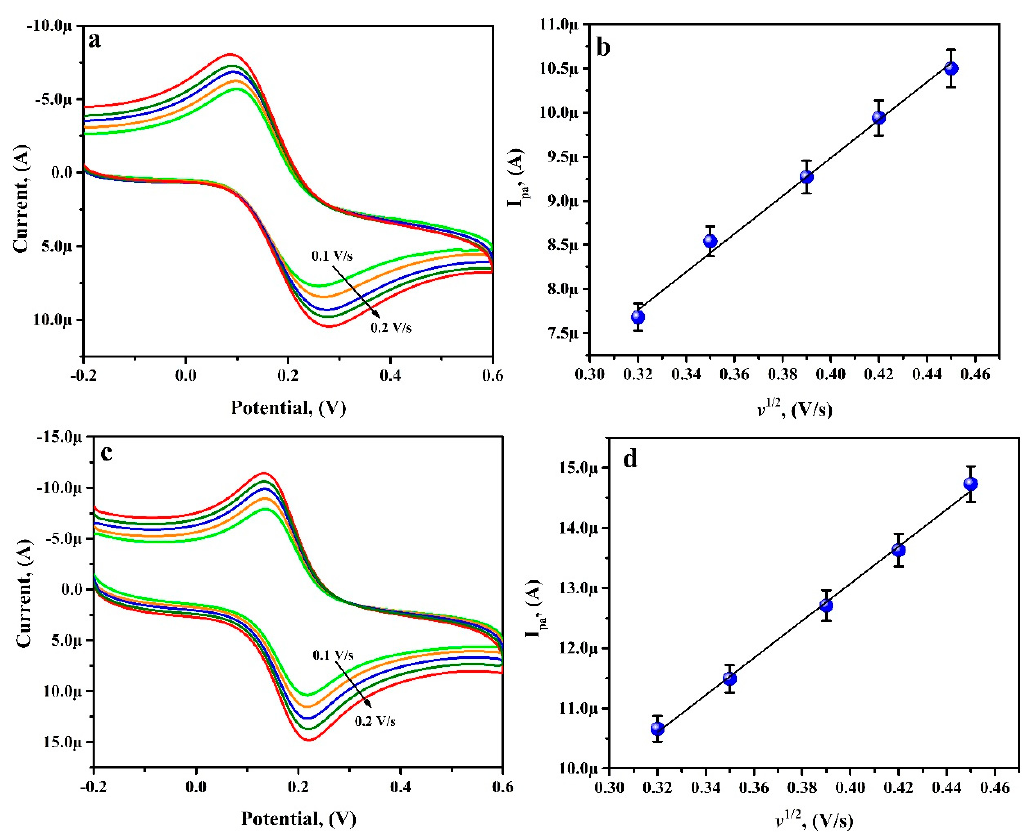
Figure 3. ( a ) CVs of K 4 [Fe(CN) 6 ] (1.0 mM) in KCl (0.1 M) on the BGPE by changing scan rates (0.1 − 0.2 V/s). ( b ) Plot of I pa versus ʋ 1/2 . ( c ) CVs obtained for PGAMGPE in the same electrolytic solution at different scan rates from 0.1 to 0.2 V/s. ( d ) Plot of I pa versus ʋ 1/2 .